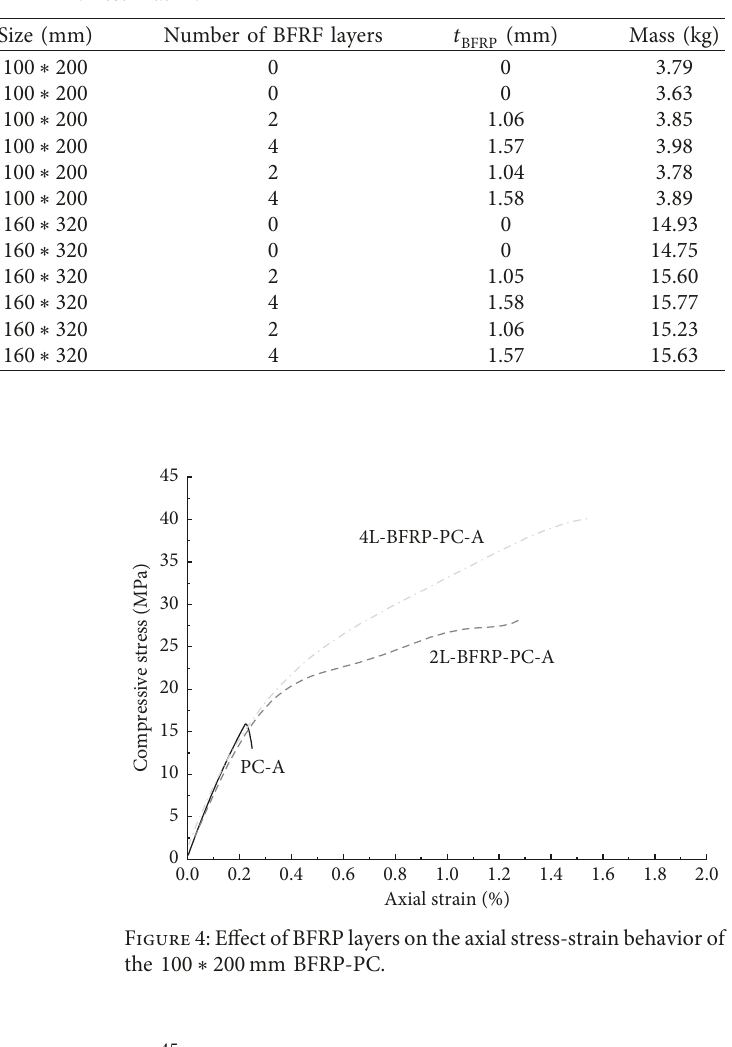
Figure 3: Layout of the compression test.